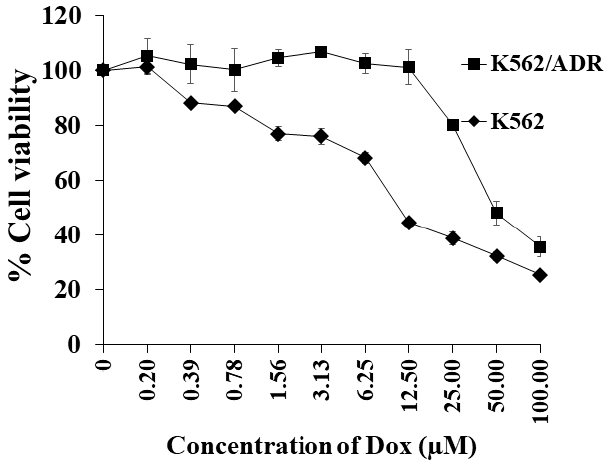
Figure 2. Effects of doxorubicin (Dox) on the cytotoxicity in drug-resistant K562/ADR and drug- sensitive K562 cells.